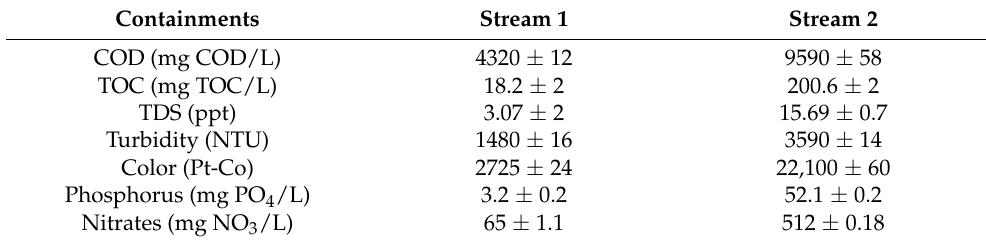
Table 1. Characteristics of two local wastewater